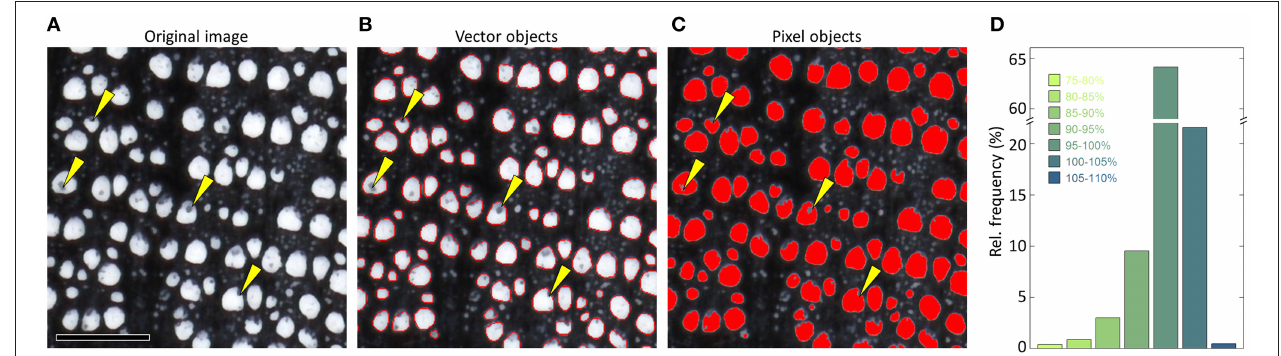
FIGURE 11 | Defining the anatomical features in a (A) sub-optimal image of Quercus petraea (surface scan, 2400 dpi) as (B) vector instead of (C) pixel objects allows to correct some sample artifacts, e.g., by applying a convex outline filter. Panel (D) compares the percent deviation of vessel lumen area when representing the identical vessels in the selected image as pixels vs. vectors after analyzing the entire sample ( > 2500 vessels) with the image-analysis tool ROXAS. 20.2% of the measured values deviate by ≥ 5% from the supposedly more accurate vector object value, and 4.3% by ≥ 10%. While underestimation of lumen area in the pixel representation can be very strong due to artifacts as highlighted by the yellow arrows in (A–C) , pixel representation also resulted in slight overestimation ( < 5%) of 21.6% of all vessels because of pixel rounding effects. Note that some of these deviations can be significantly reduced by manual editing. Scale bar = 1mm.